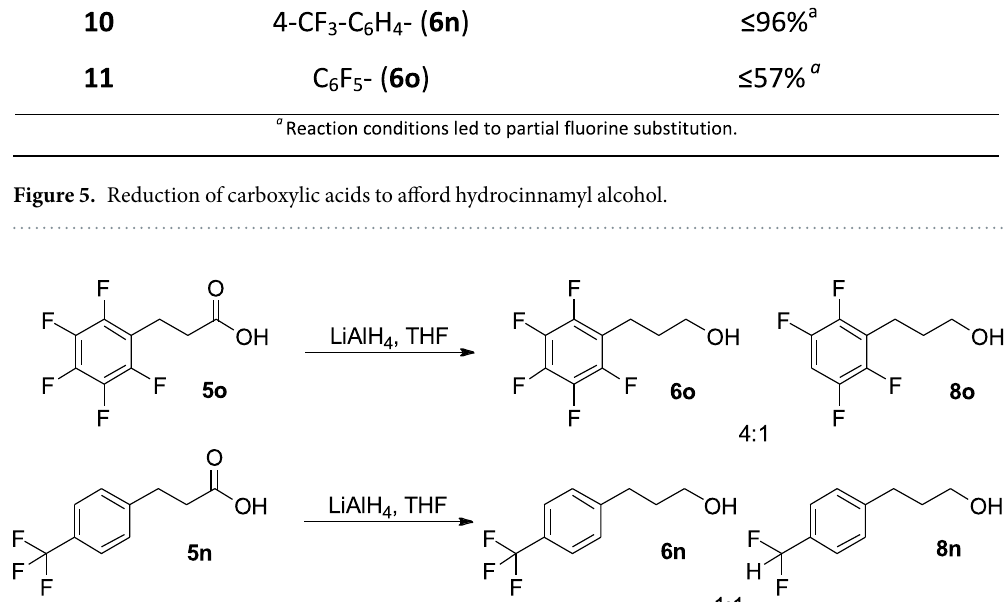
Figure 6. By-products formed during the lithium aluminium hydride reduction of fluorinated hydrocinnamic